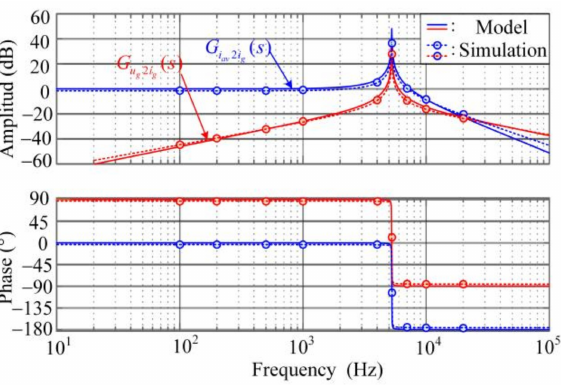
Figure 3. Bode diagrams and simulation data of various transfer